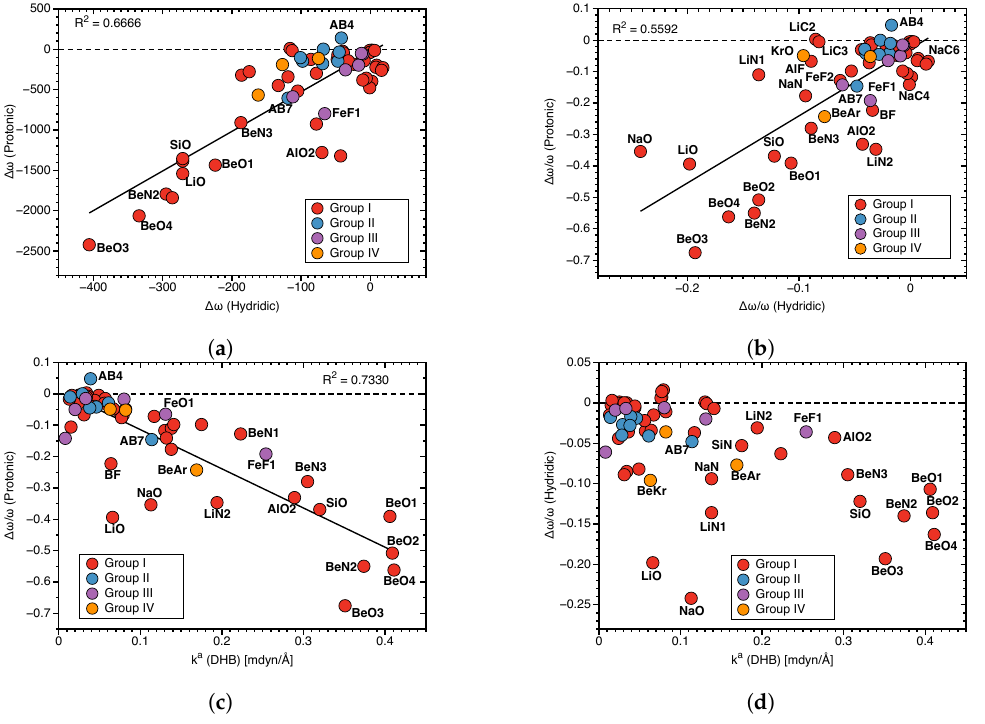
Figure 7. ( a ) Correlation between local mode frequency shifts ∆ ω (Hydridic) and ∆ ω (Protonic). ( b ) Correlation between the relative frequency shifts ∆ ω / ω (Hydridic) and ∆ ω / ω (Protonic). ( c ) Cor- relation between ∆ ω / ω (Protonic) and k a (DHB). ( d ) Correlation between ∆ ω / ω (Hydridic) and k a